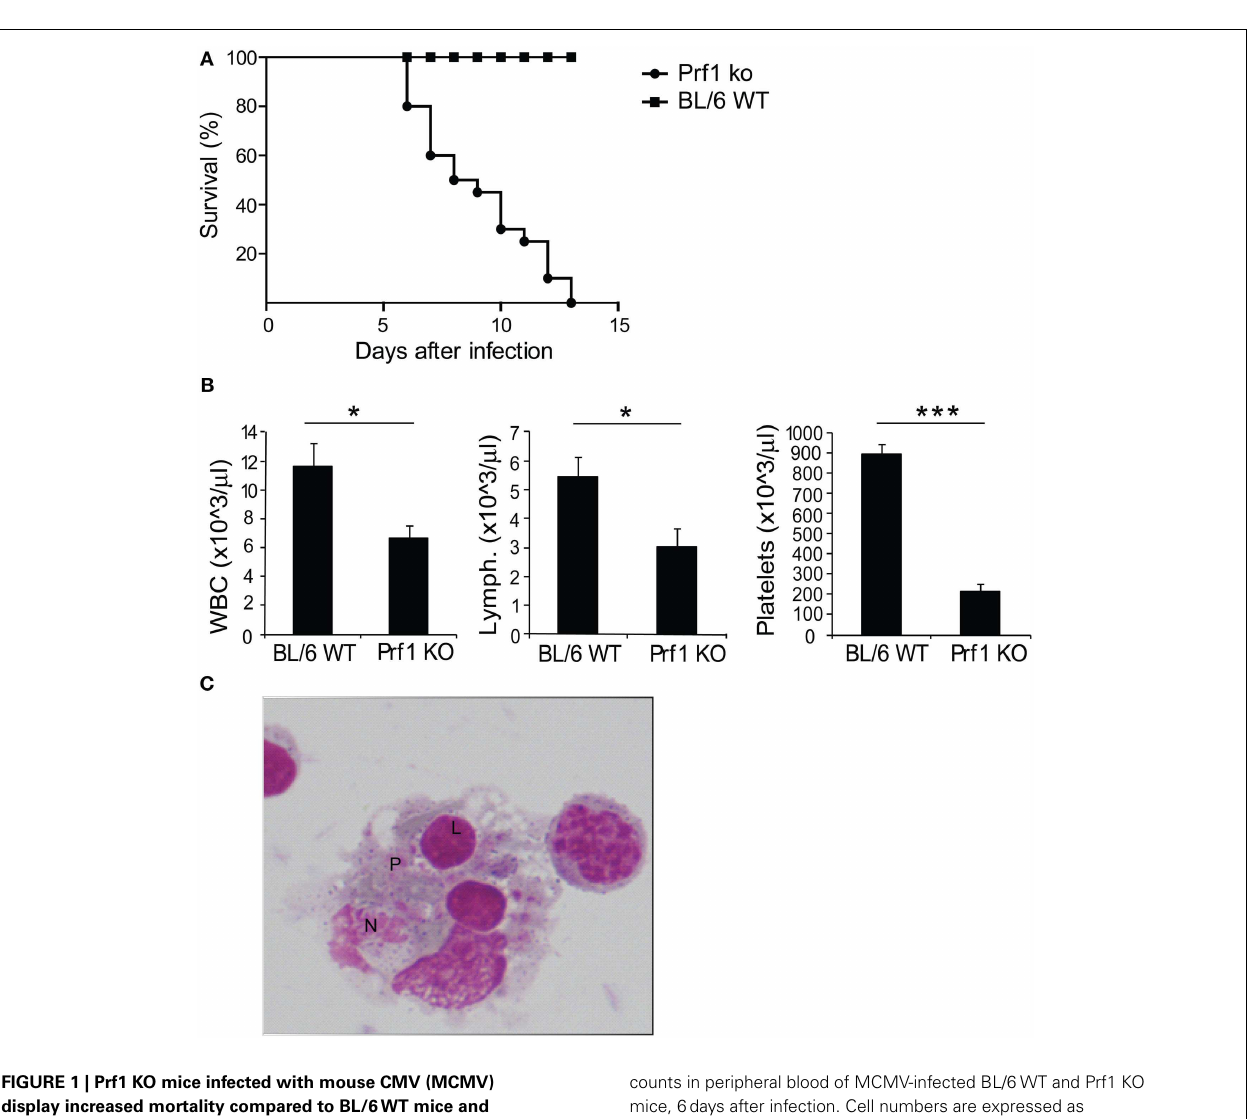
counts in peripheral blood of MCMV-infected BL/6WT and Prf1 KO mice, 6days after infection. Cell numbers are expressed as mean ± SEM. N = 4 mice per group. * p < 0.05; *** p < 0.001. (C) Hemophagocytosis in the bone marrow of MCMV-infected Prf1 KO mice: activated macrophages engulfing platelets (P), lymphocytes (L), neutrophils (N). Magnification ×